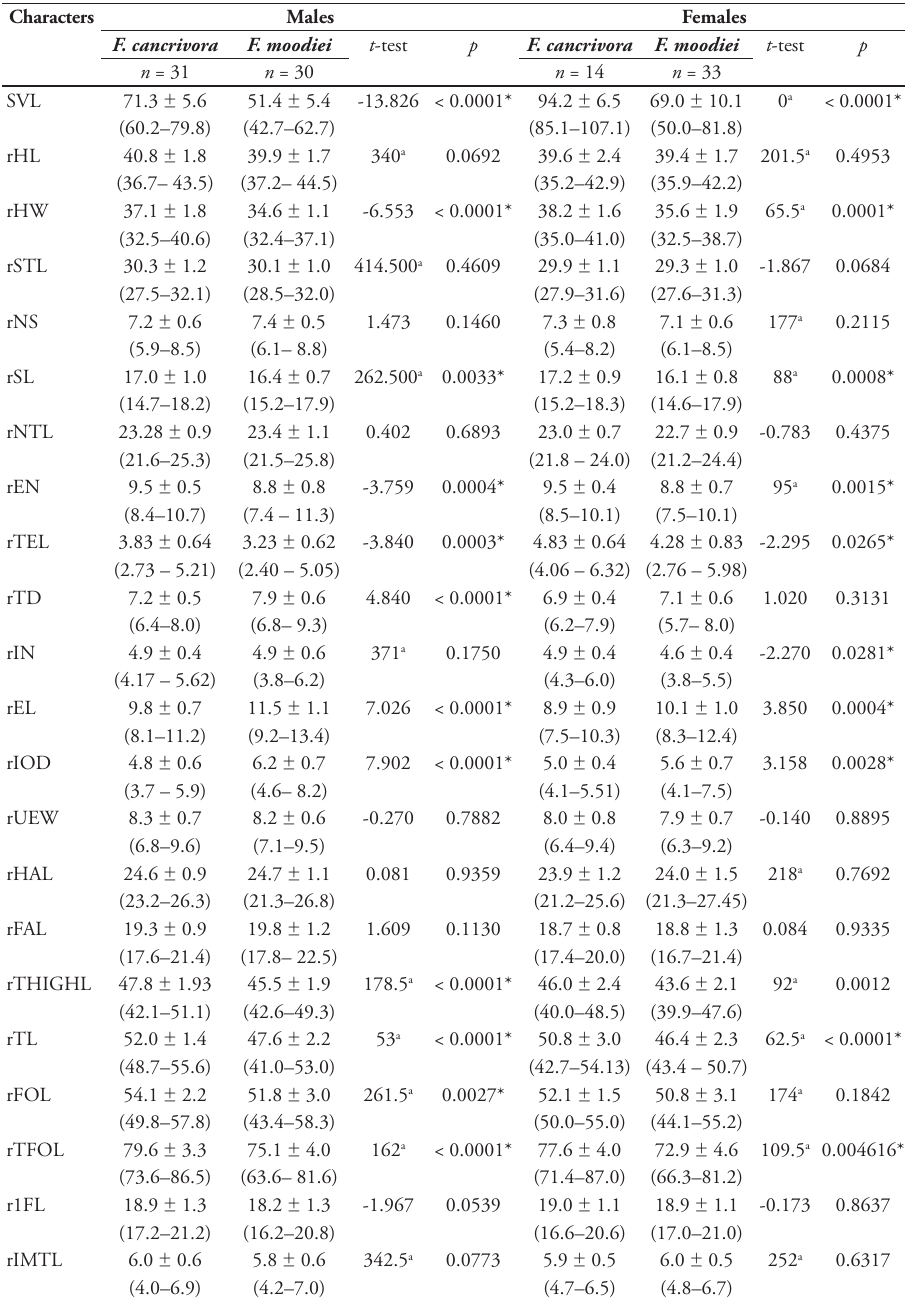
Table 4. Comparisons of body sizes of Fejervarya cancrivora and F. moodiei . Data are given as mean and standard deviation, followed by range in parentheses. Key: a tested by Mann-Whitney U test, * significance level at p <